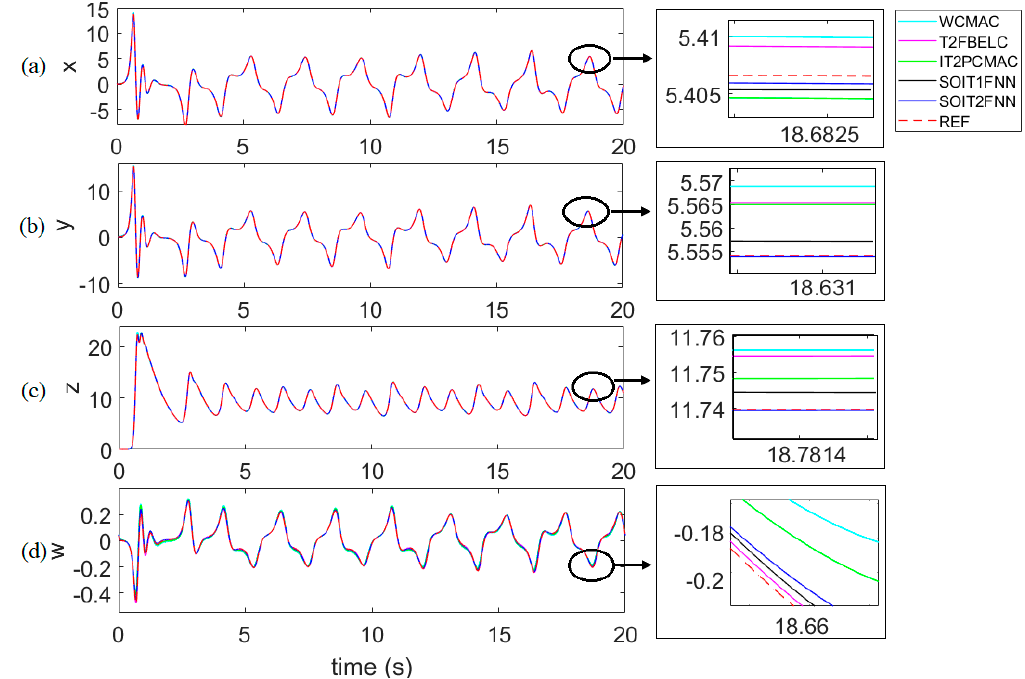
Figure 18. System outputs between the proposed SRIT2PC and other synchronization methods for Case 3: ( a ) x 1 , x 2 , ( b ) y 1 , y 2 , ( c ) z 1 , z 2 , and ( d ) w 1 , w 2 .